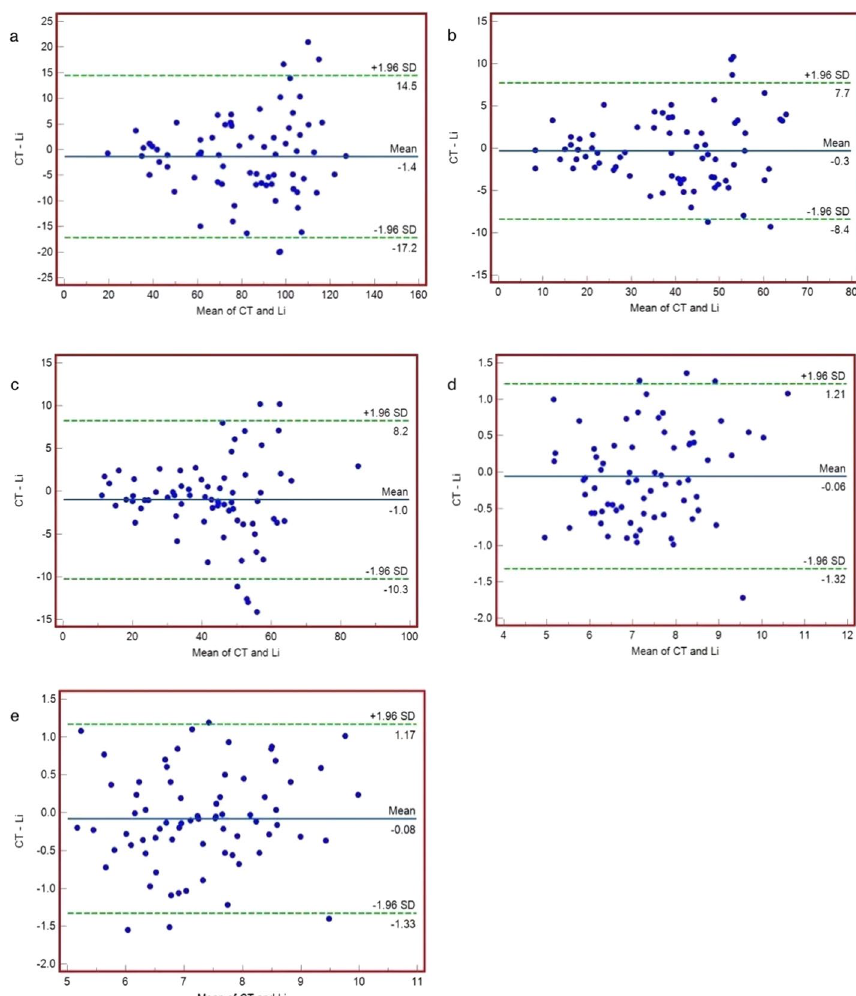
Fig. 4 Bland–Altman plots of the values were determined by CT and the Li-Qian formula in 72 patients. Note: In the figure, the three solid lines from top to bottom are the upper limit of agreement (LOA) of the difference (Xd 1.96Sd), the mean of the difference (Xd), and the lower limit of the difference (LOA) + (Xd-1.96Sd). Xd: mean of the difference; Sd: standard deviation of the difference. a total renal GFR values; b